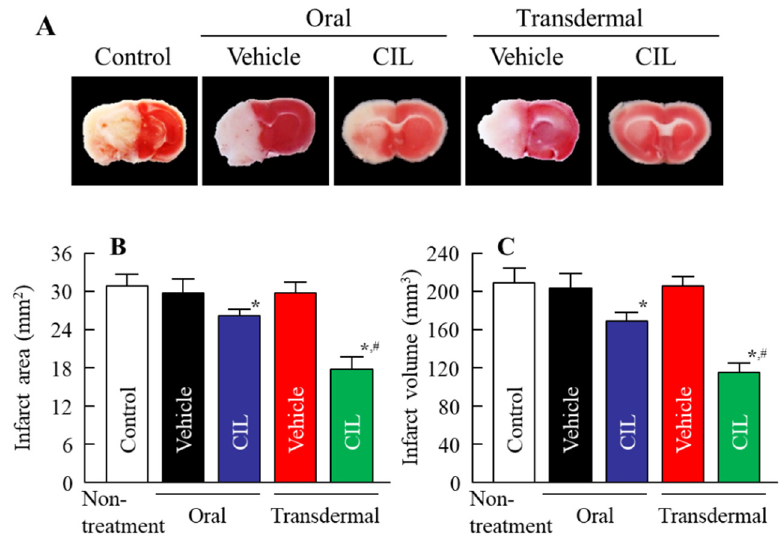
Figure 7. Protective effect of CIL-Ngel on ischemic stroke in MCAO/reperfusion model mice. ( A ) Image of the brain of MCAO/reperfusion model mice following the oral and transdermal administration of CIL. ( B , C ) Infarct area ( B ) and volume ( C ) of MCAO/reperfusion model mice following the oral and transdermal administration of CIL. The mice were separated randomly into 5 groups, and infarct area was measured by the person who was blind to the group. The CIL-Ngel was transdermally administered once a day for 3 days. n = 5–9. * p < 0.05 vs. control for each category, # p < 0.05 vs. CIL orally treated MCAO/reperfusion model mice for each category. The CIL-Ngel attenuated ischemic stroke, and the therapeutic effect was higher than that following the oral administration of CIL powder.